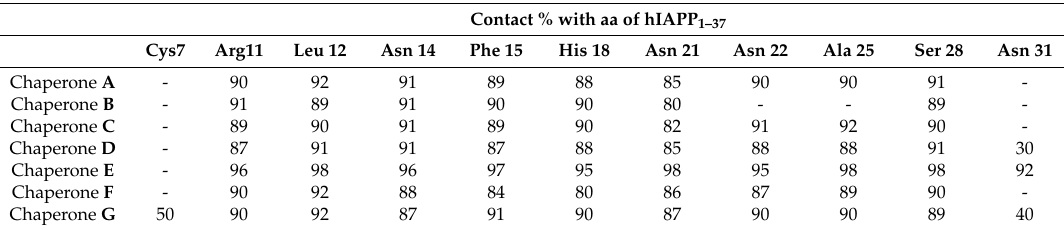
Table 2. In silico determination of contact percent of the pharmaco-chaperones with the amino acids of IAPP 1–37 involved in the